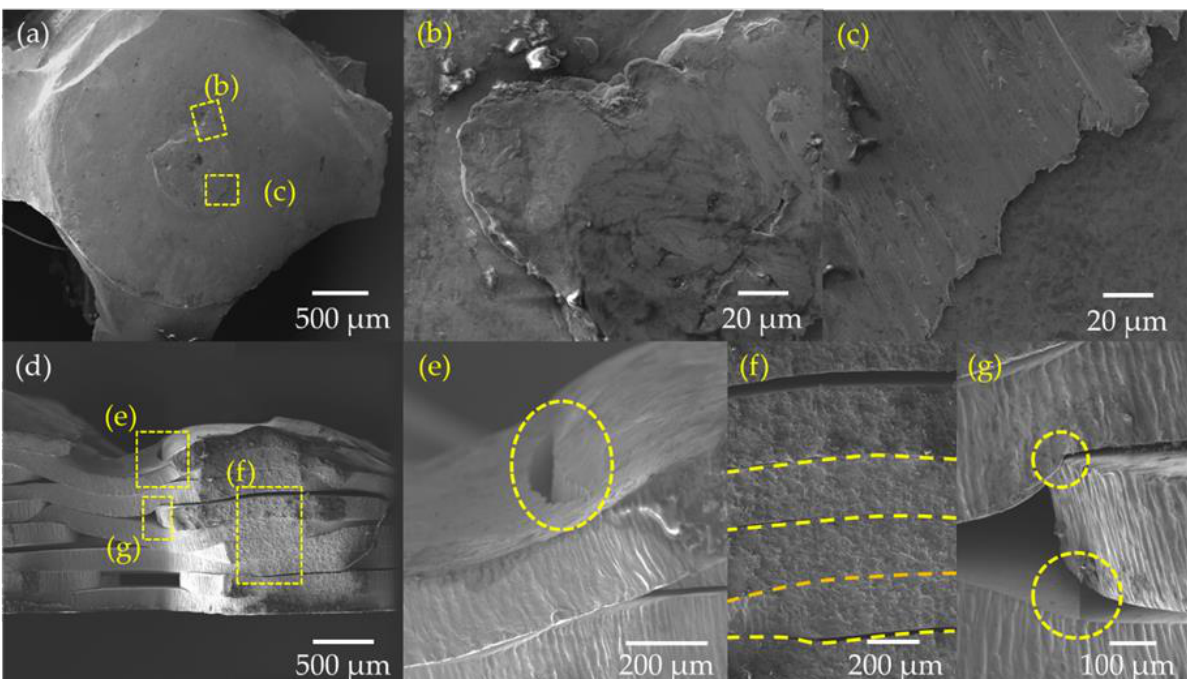
Figure 14. Fractographies of ( a ) micro-spot weld, ( b ) and ( c ) shear leaps of flat ductile fractures, ( d ) lateral view of the collapsed sheets, ( e ) crack due to collapse of sheets marked with a yellow circle, ( f ) close view of the thickness variations in the collapsed sheets, and ( g ) embedded zones with plastic deformation marked with yellow circles.